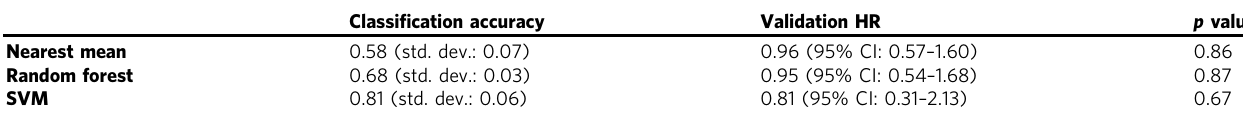
Table 1 Classi fi cation accuracy in cross-validation and HR in independent validation for the classi fi ers trained on labels based on the top 25% surviving bortezomib patients and the bottom 25% nonbortezomib